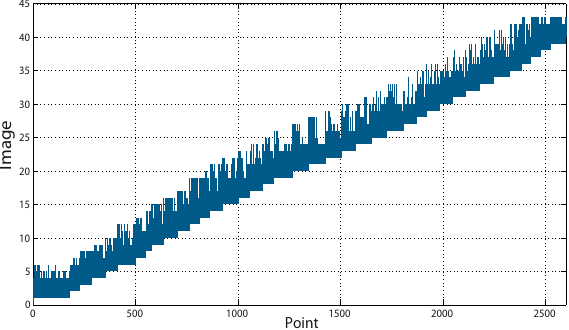
Figure 1: Indices of the images in the sequence in which each object point was